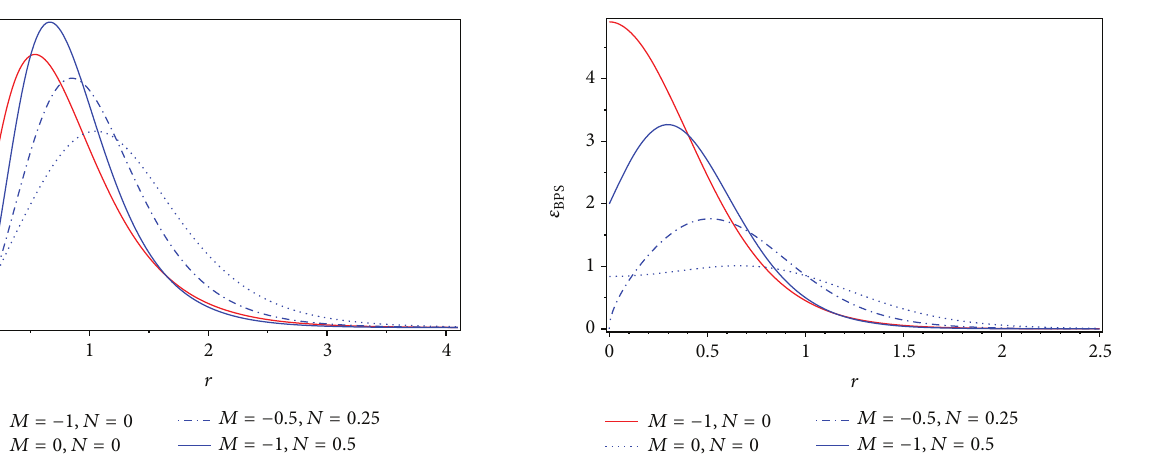
Figure3:Theprofilesoftheelectricfield 𝐸(𝑟) = 𝐴 󸀠 0 (𝑟) for 𝑛 = 1 .The red lines represent the solutions for a |𝜙| 4 potential and blue lines for |𝜙| 6 potentials.